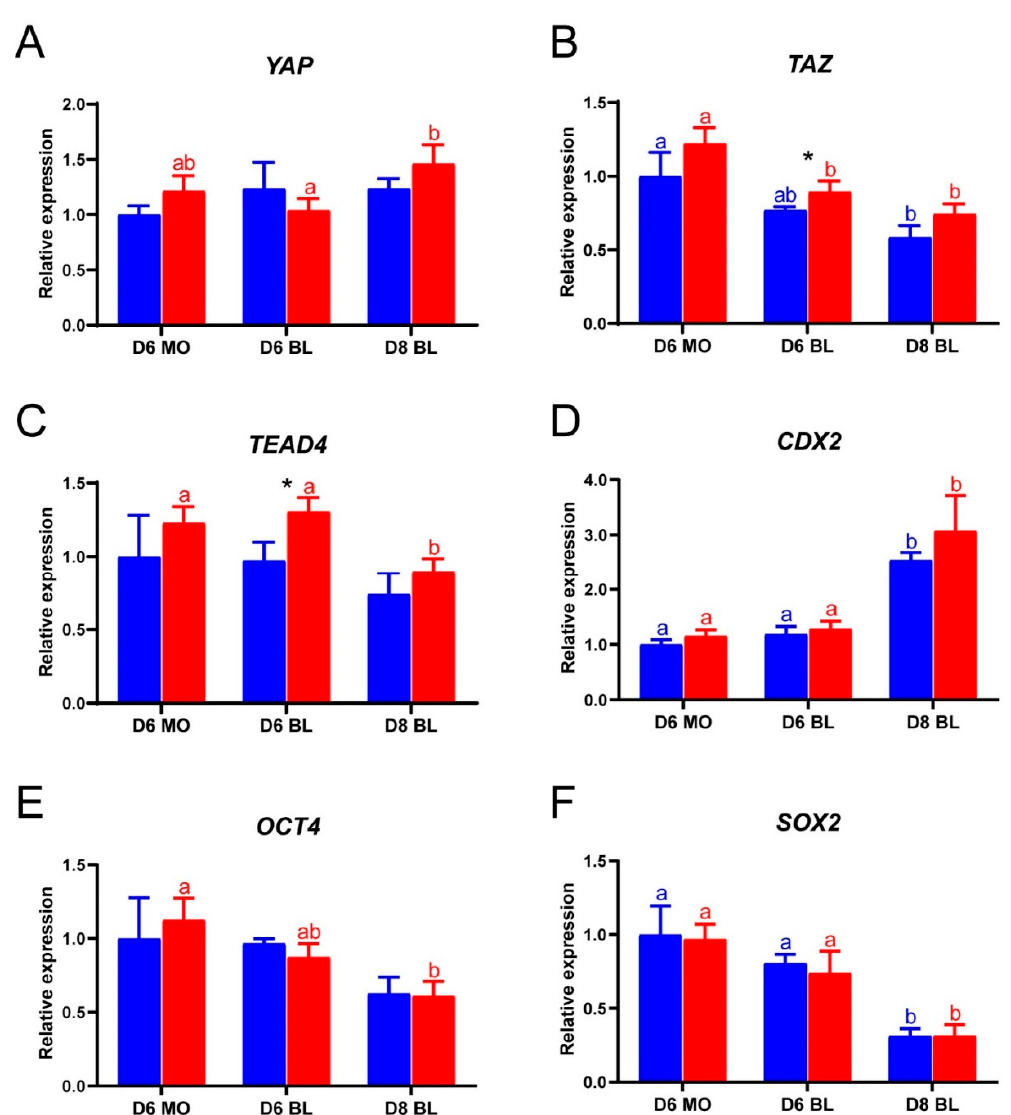
Figure 2. The relative expression of Hippo pathway and pluripotency genes in bovine embryos cultured in the absence of LPA (blue) and in the presence of 10 − 5 M LPA (red), as determined by quantitative RT-PCR. ( A ) YAP , ( B ) TAZ , ( C ) TEAD4 , ( D ) CDX2 , ( E ) OCT4 , ( F ) SOX2 . Relative expression from control embryos was set at 1; * ( p < 0.05) indicates a significant difference between embryos cultured with and without LPA. Significant differences between developmental stages are presented by different letters with the same color ( p < 0.05). Error bars indicate standard deviations of three biological replicates. D = day, MO = morula, BL = blastocyst.